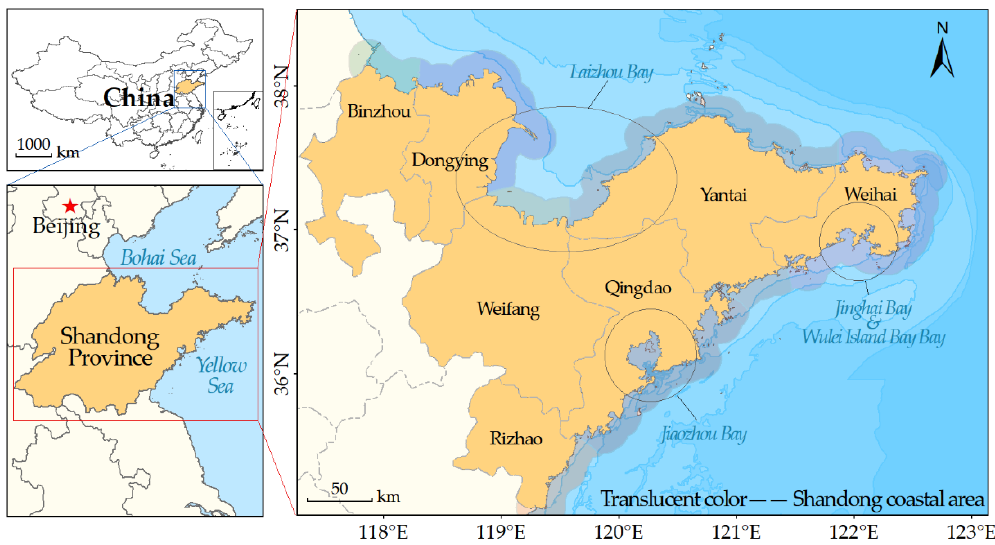
Figure 1. Geographical location of the Shandong Province.